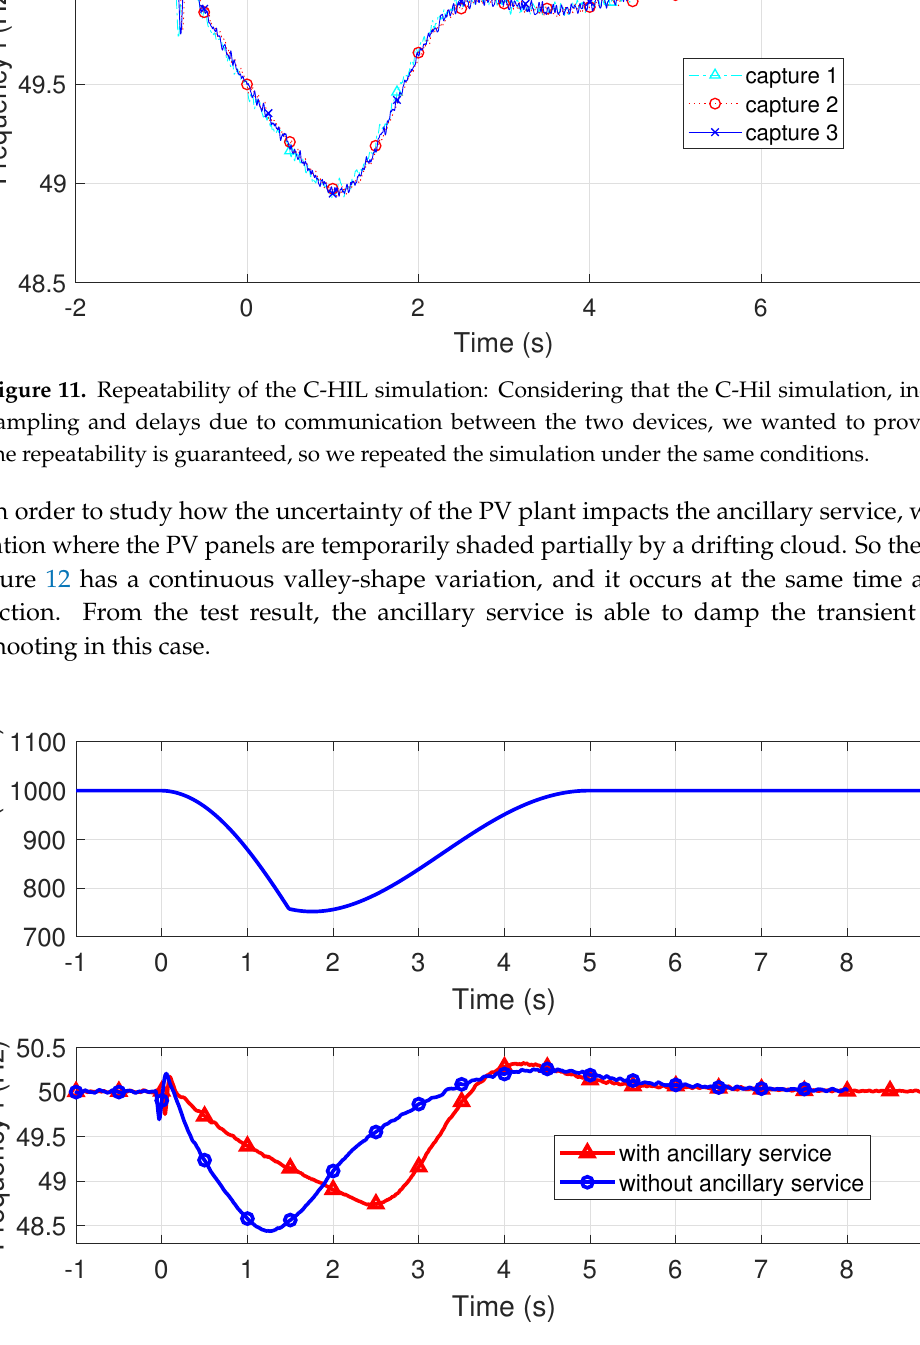
Figure 12. PV irradiance’s influence on the frequency dynamic. In this figure it is shown the effect of a sudden change of radiation during the frequency regulation